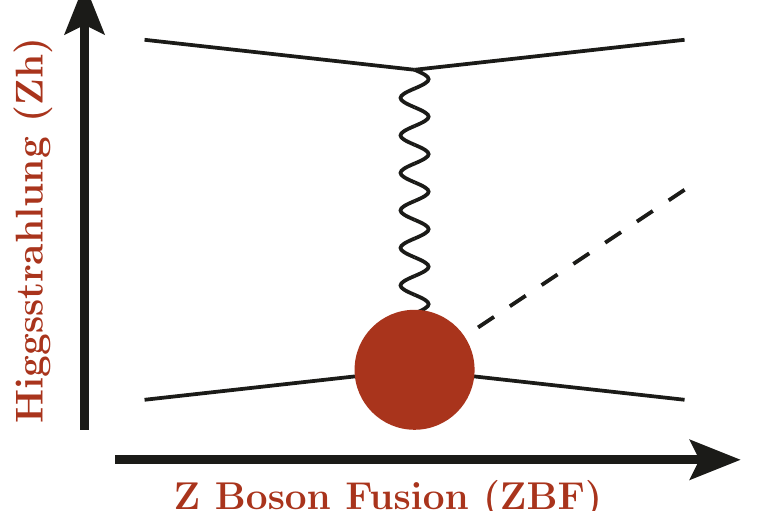
Figure 2. Crossing symmetry that relates the Zh and ZBF Higgs production processes. The amplitudes of these are the same up to an exchange of the Mandelstam variables s and t , s ↔ t. In consequence, the same direction in SMEFT space control Zh at high s and ZBF at high t